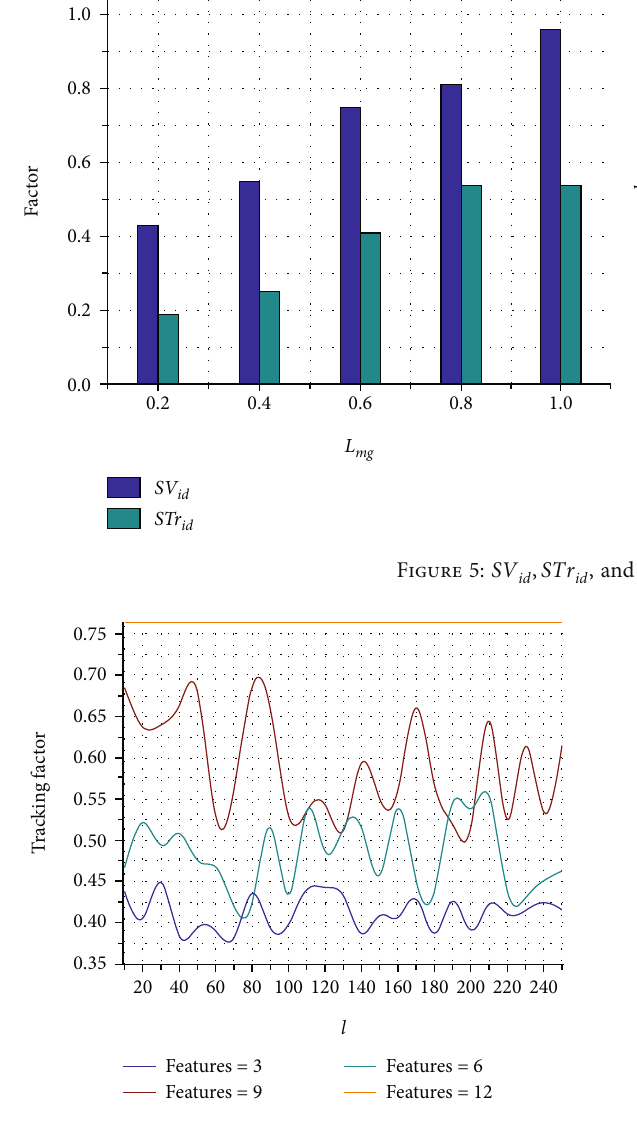
Figure 6: Tracking factor for the varying l and